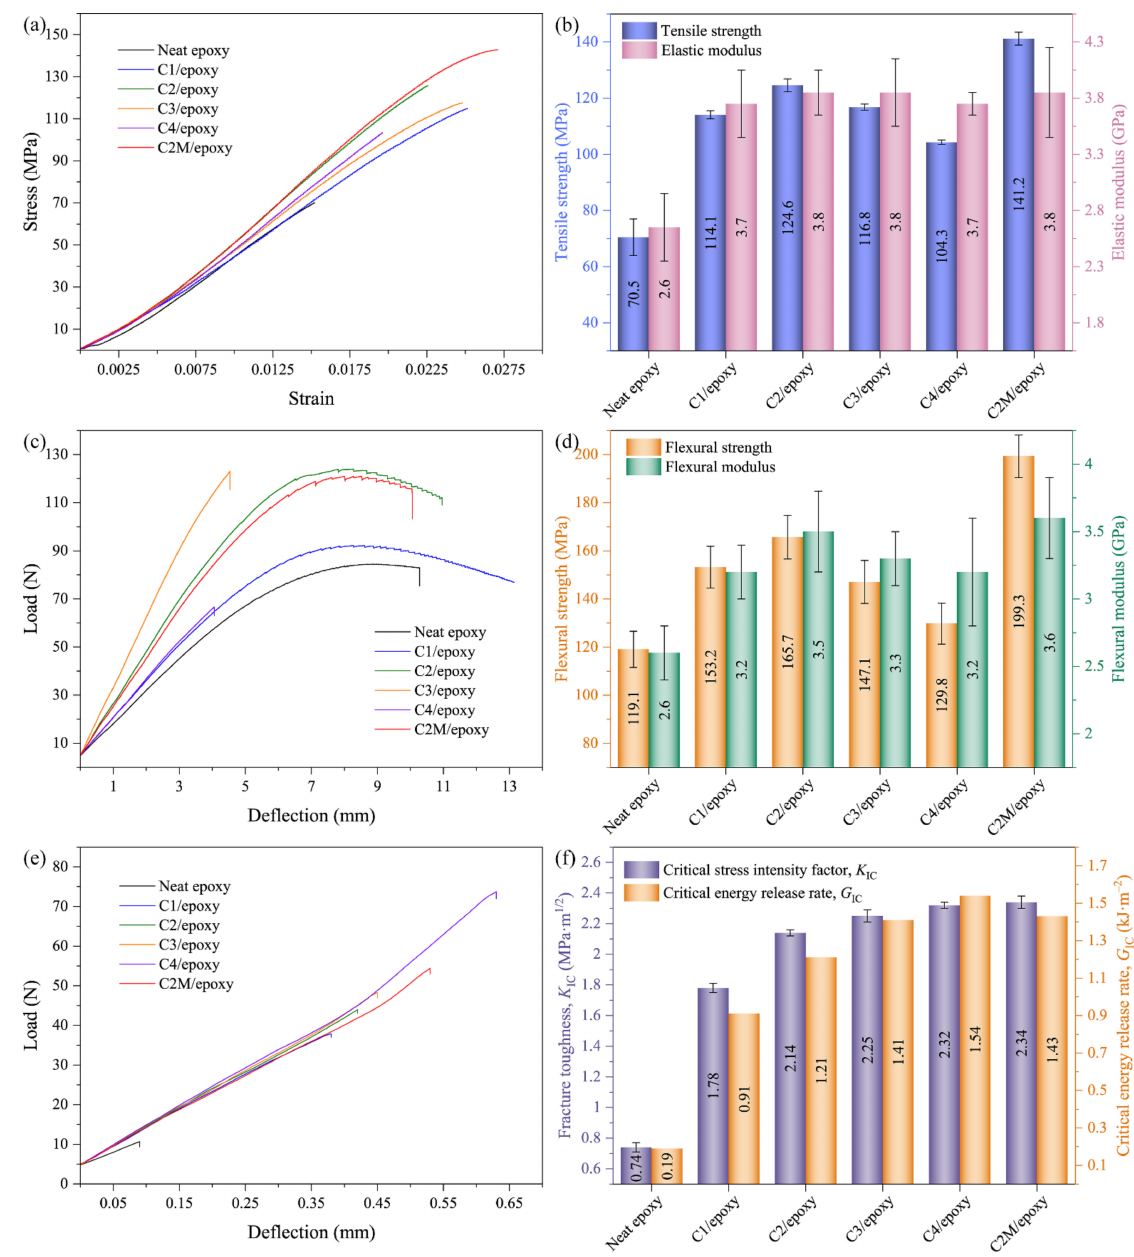
Figure 5. ( a ) Typical stress-strain curves in tension, ( b ) elastic modulus and tensile strength, ( c ) typical load-deflection curves in bending, ( d ) flexural modulus and flexural strength, ( e ) typical load-deflection curves in fracture toughness, ( f ) fracture toughness and critical energy release rate values of fracture toughness of ACSF/epoxy composites and MXene functionalized ACSF/epoxy